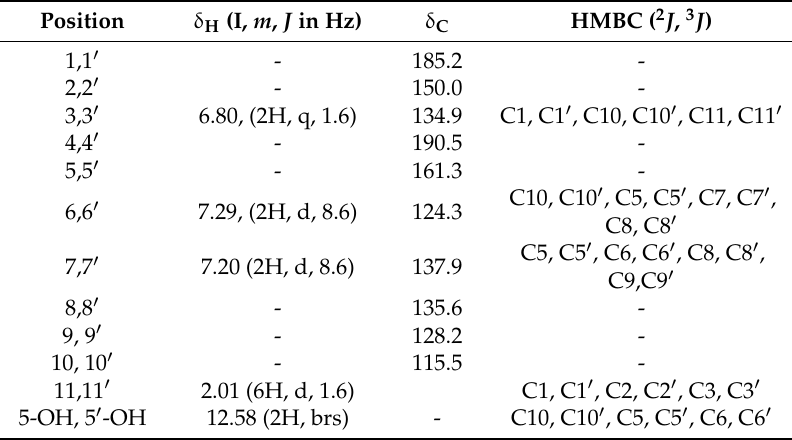
Table 1. 1 H and 13 C-NMR data for 8,8 1 -oxo-biplumbagin ( 1 ).